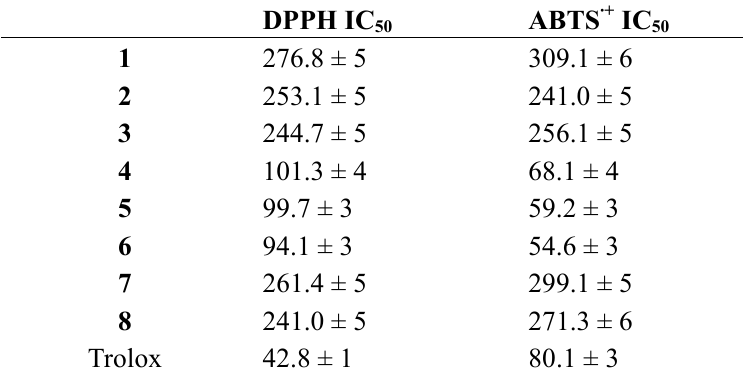
Table 4. Free radical scavenging activity of compounds 1 – 8 evaluated with DPPH, ABTS ·+ assays (IC , μ 50